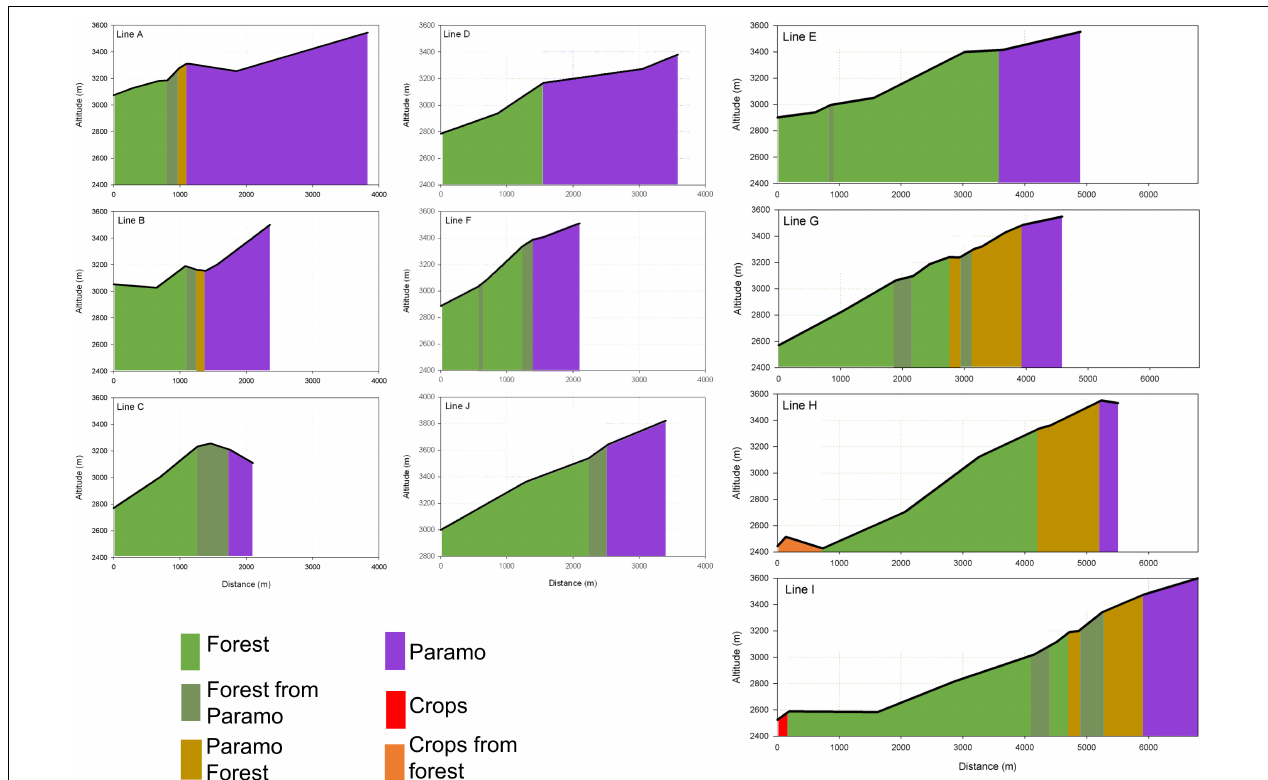
FIGURE 4 | Profile diagrams of the main ecosystems sequence along with the horizontal distance and altitude for the Capaz study area. Letter identification corresponds with the ten lines indicated in Figure 2 .